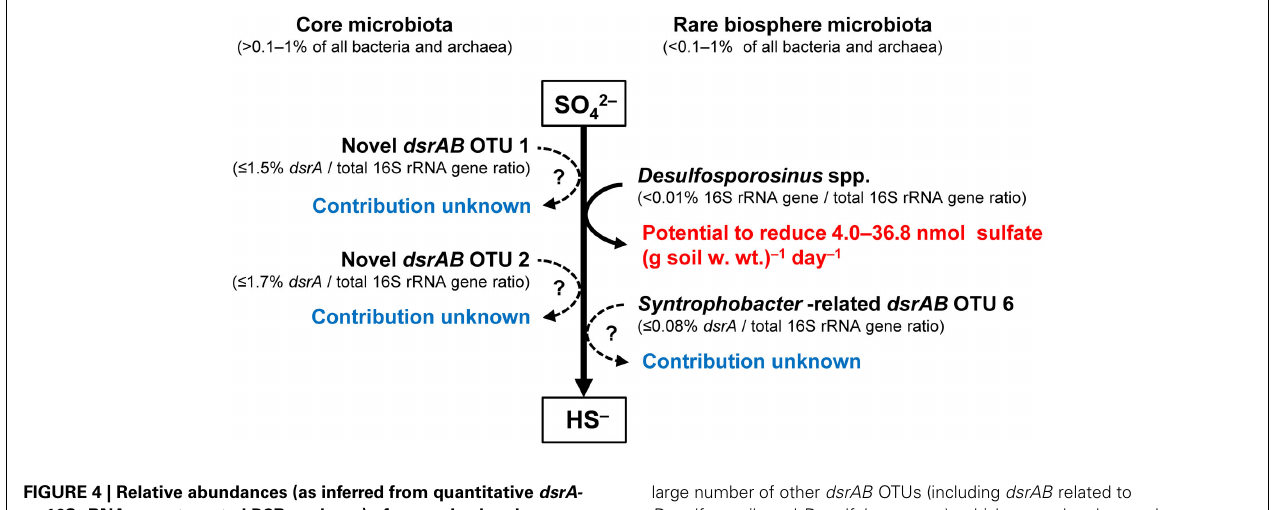
FIGURE 4 | Relative abundances (as inferred from quantitative dsrA- or 16S rRNA gene-targeted PCR analyses) of recognized and putative SRM in the model peatland Schlöppnerbrunnen II. This figure is based on data from Loy et al. (2004); Schmalenberger et al. (2007); Pester et al. (2010); Steger et al. (2011).The abundance of the